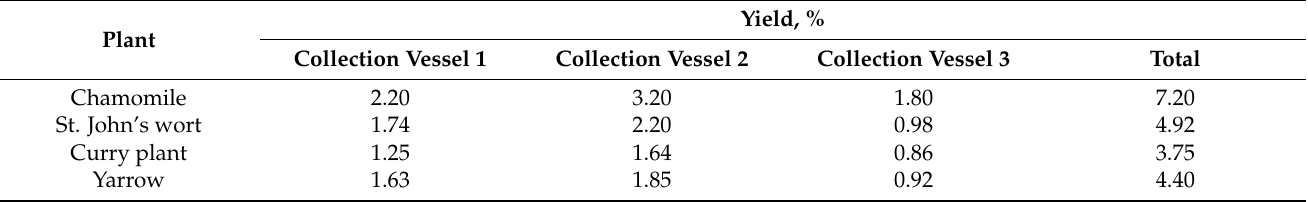
Table 1. Plant extract yields obtained with supercritical CO 2